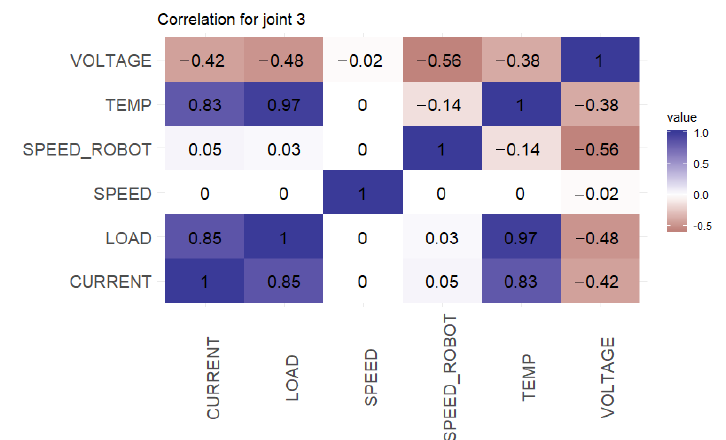
Figure 6. Correlation of joint 2.